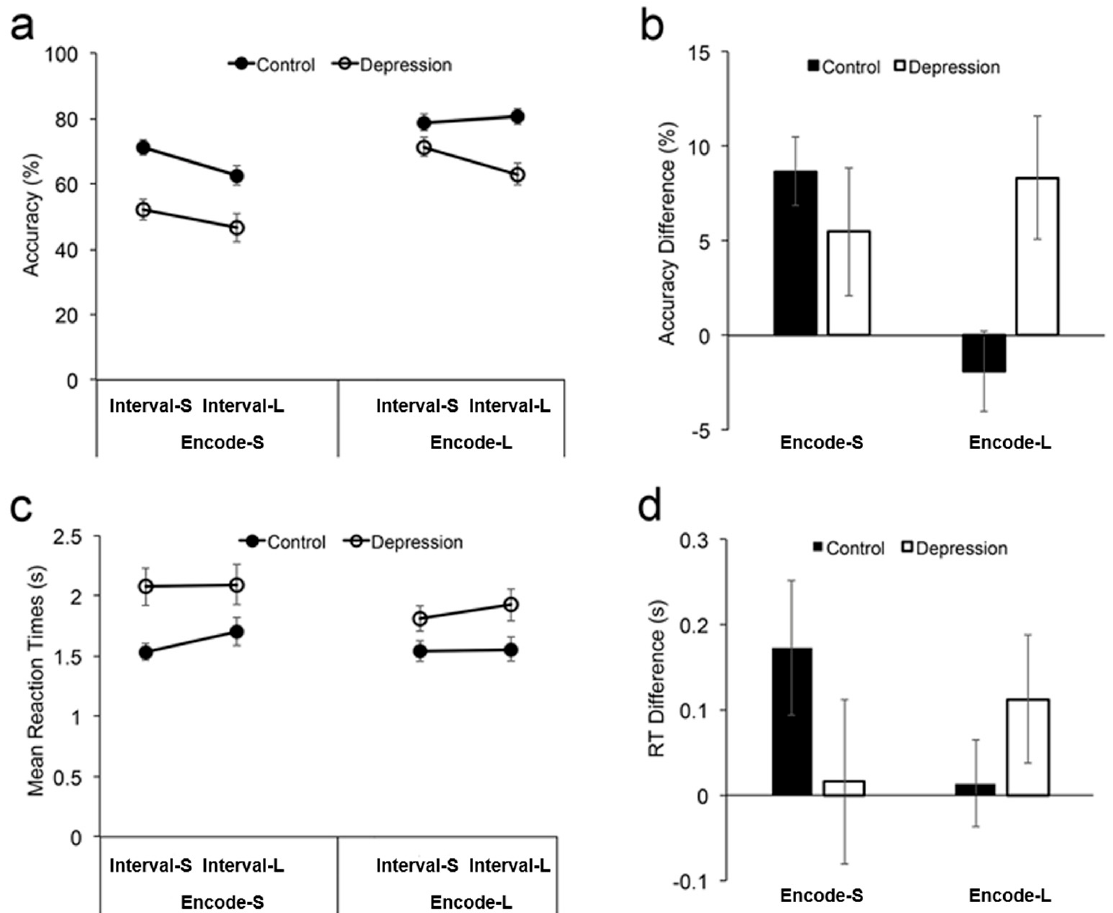
Figure 2. Accuracies ( a ) and mean reaction times (RTs) ( c ) with standard errors shown as a function of encoding time and retention time for each group. The difference in accuracy between short and long retention ( b ), and the difference in RT between long retention and short retention ( d ) with standard errors shown as a function of the encoding time for each group. Encode − S: short time for stimulus encoding; Encode − L: long time for stimulus encoding; Interval − S: short retention interval; Interval − L: long retention interval.